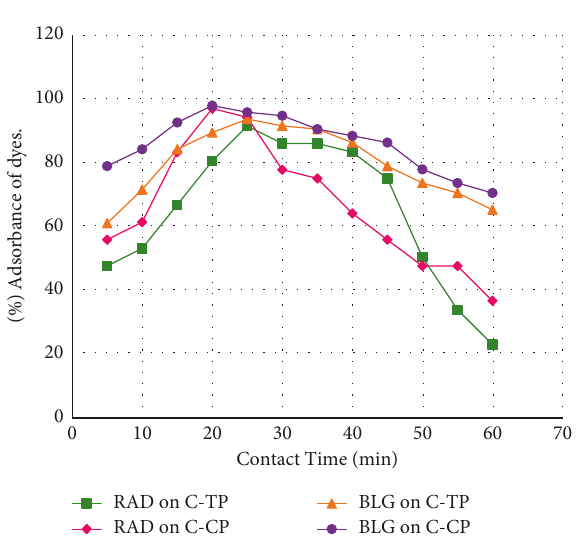
Figure 10: Contact time influence on adsorption. Initial pH � 5, final pH for RAD on C-TP and C-CP � 4, BLG on C-TP � 4.5, and BLG on C-CP �